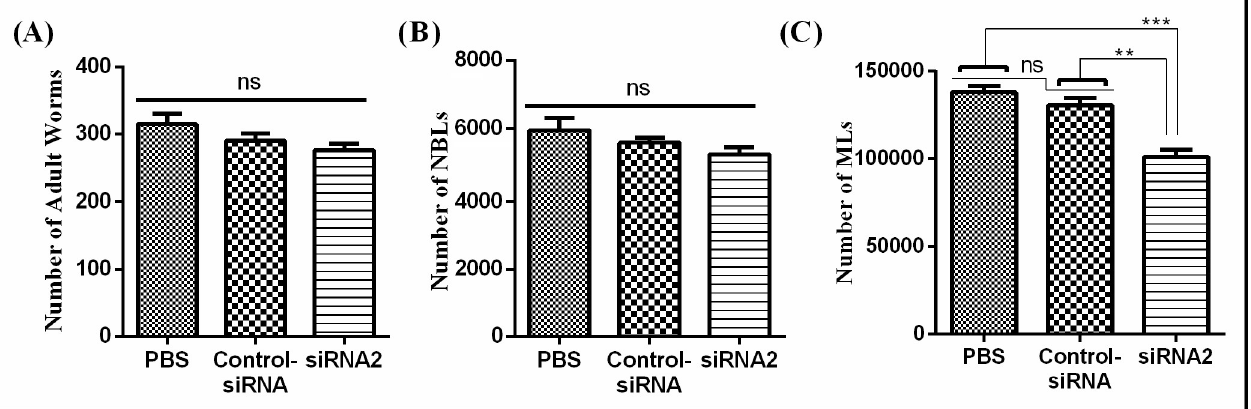
Fig 7. Infectivity of siRNA2 treated ML. A: Number of adult worms. B: Number of NBLs. C: Number of next generation MLs. The significant level was set at �� P < 0.01, ��� P < 0.001, and ns non-significant compared with control group.